Question: Identify the chart type used in this figure.
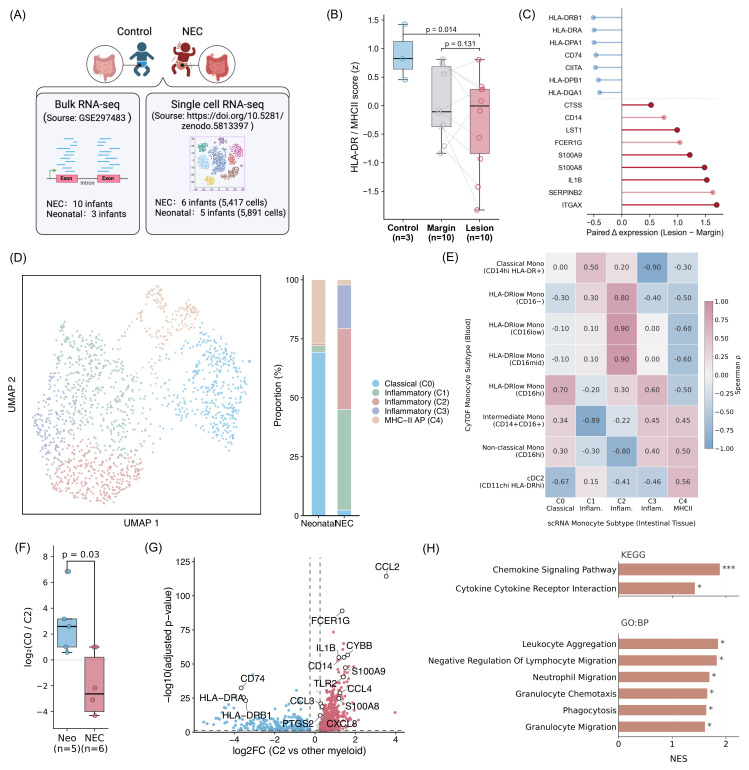
Answer: heatmap